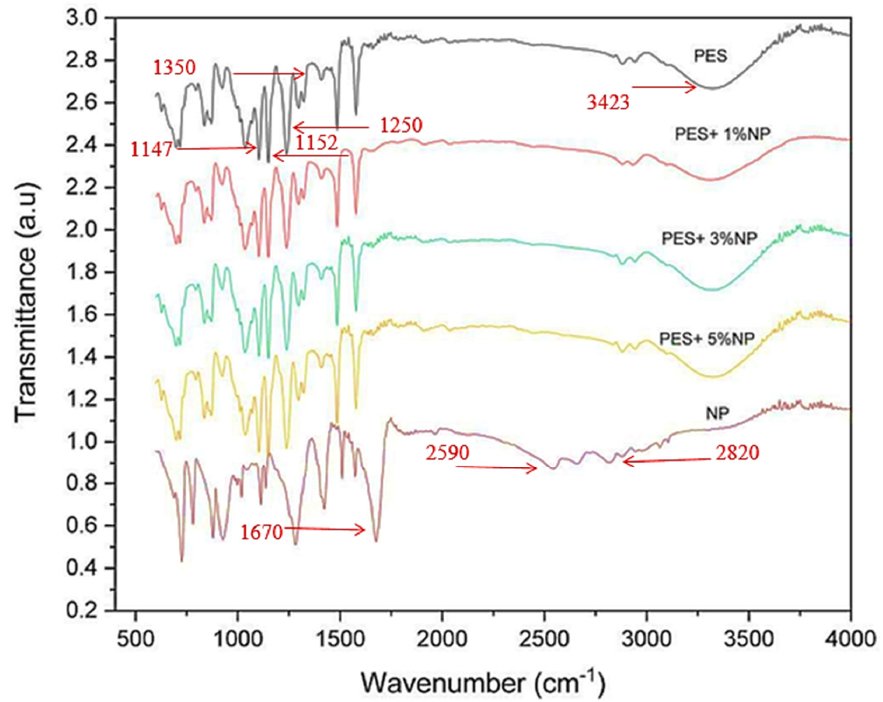
Figure 2. FTIR spectra of the bare PES and PES/TGF